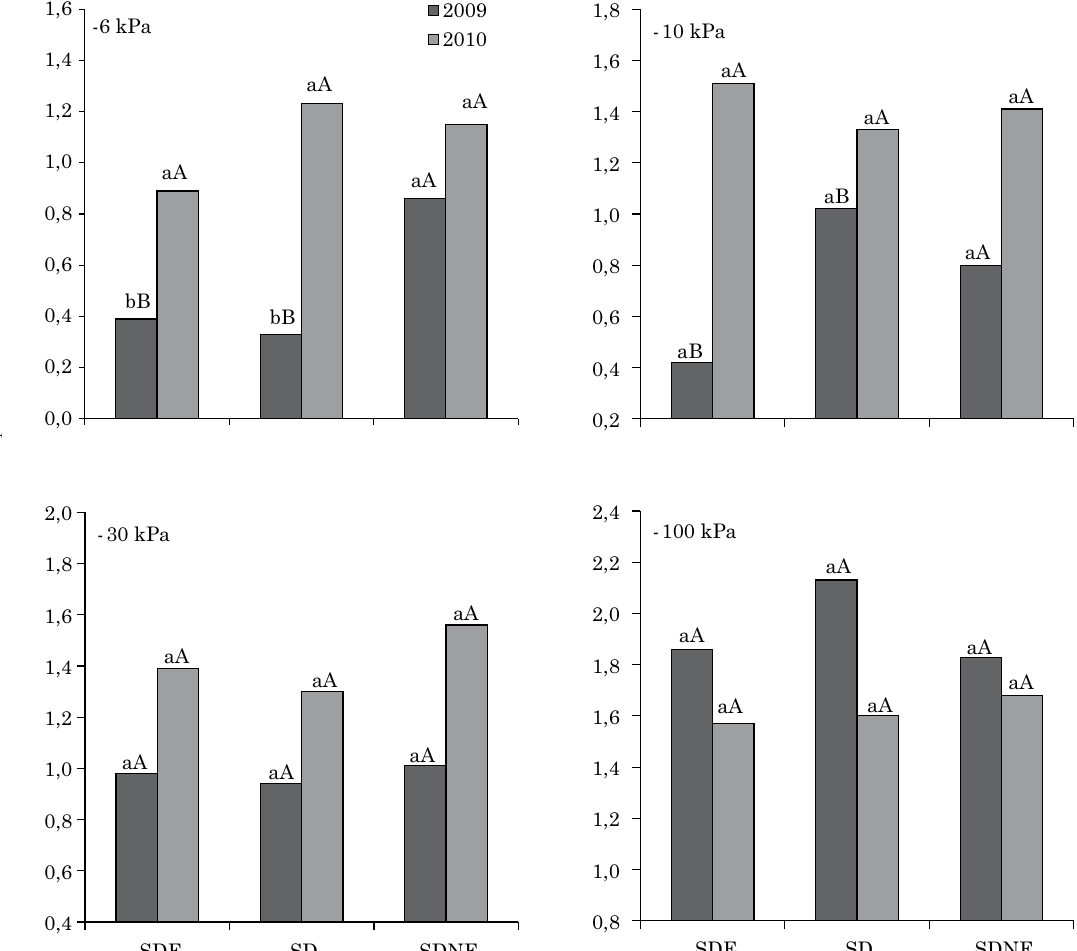
Figura 2. Valores médios de log K 1 (índice de continuidade, K 1 ) para a camada de 0,00-0,05 m em diferentes potenciais mátricos, para a cama de semeadura do milho (2009) e da soja (2010) com semeadura direta escarificada (SDE), semeadura direta (SD) e semeadura direta cultivada com nabo forrageiro (SDNF). Barras seguidas de mesma letra minúscula indicam que as médias dos tratamentos não diferem em cada ano e as seguidas de mesma letra maiúscula indicam que as médias entre os anos dentro de cada tratamento não diferiram pelo teste Tukey a 5